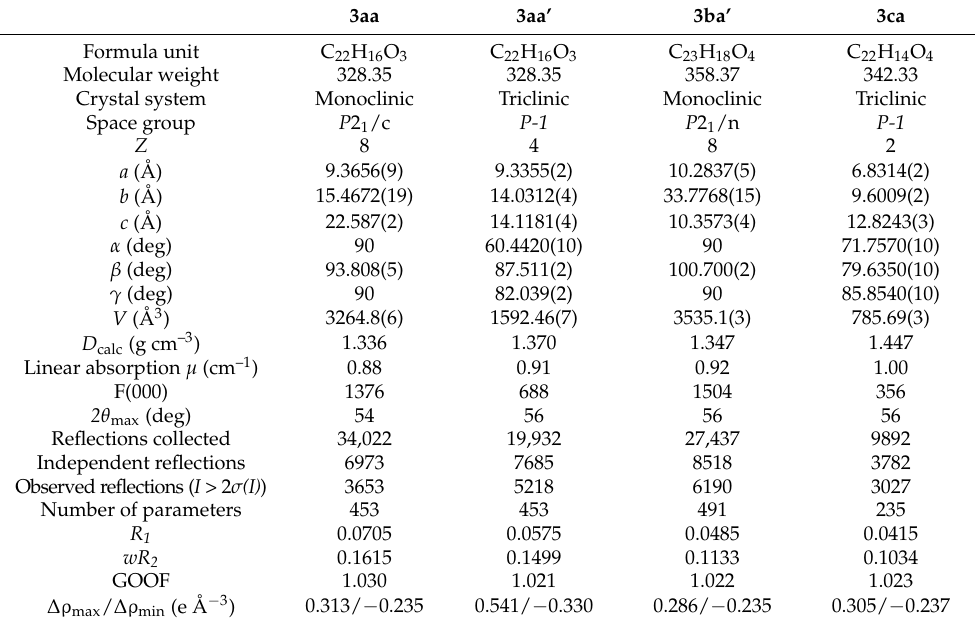
Table 2. Crystal data and structure refinement parameters for 3aa , 3aa’ , 3ba’ , and 3ca